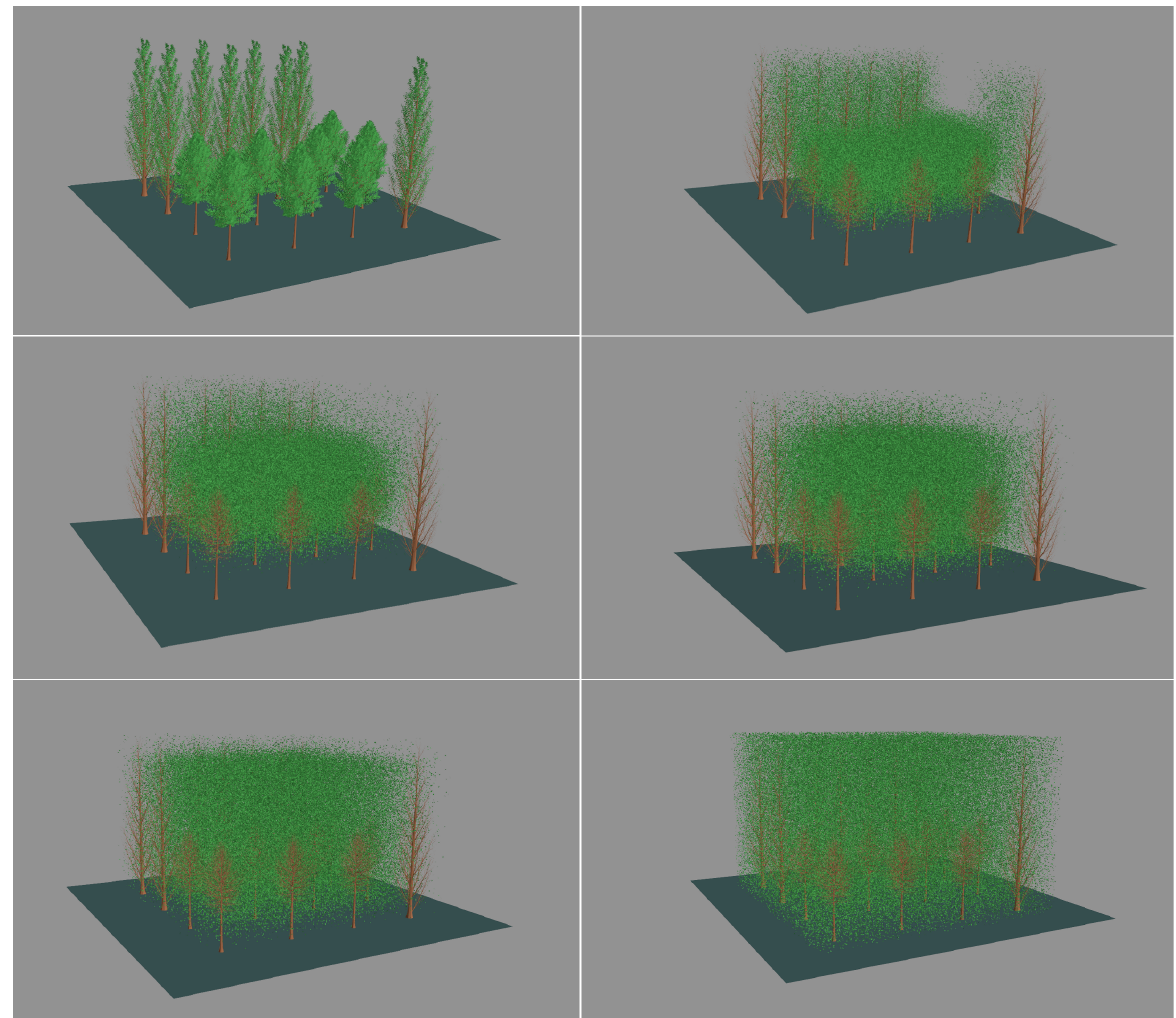
Figure 4: Different degrees of foliage dispersion for a constructed mixed virtual scene, representing poplar and aspen